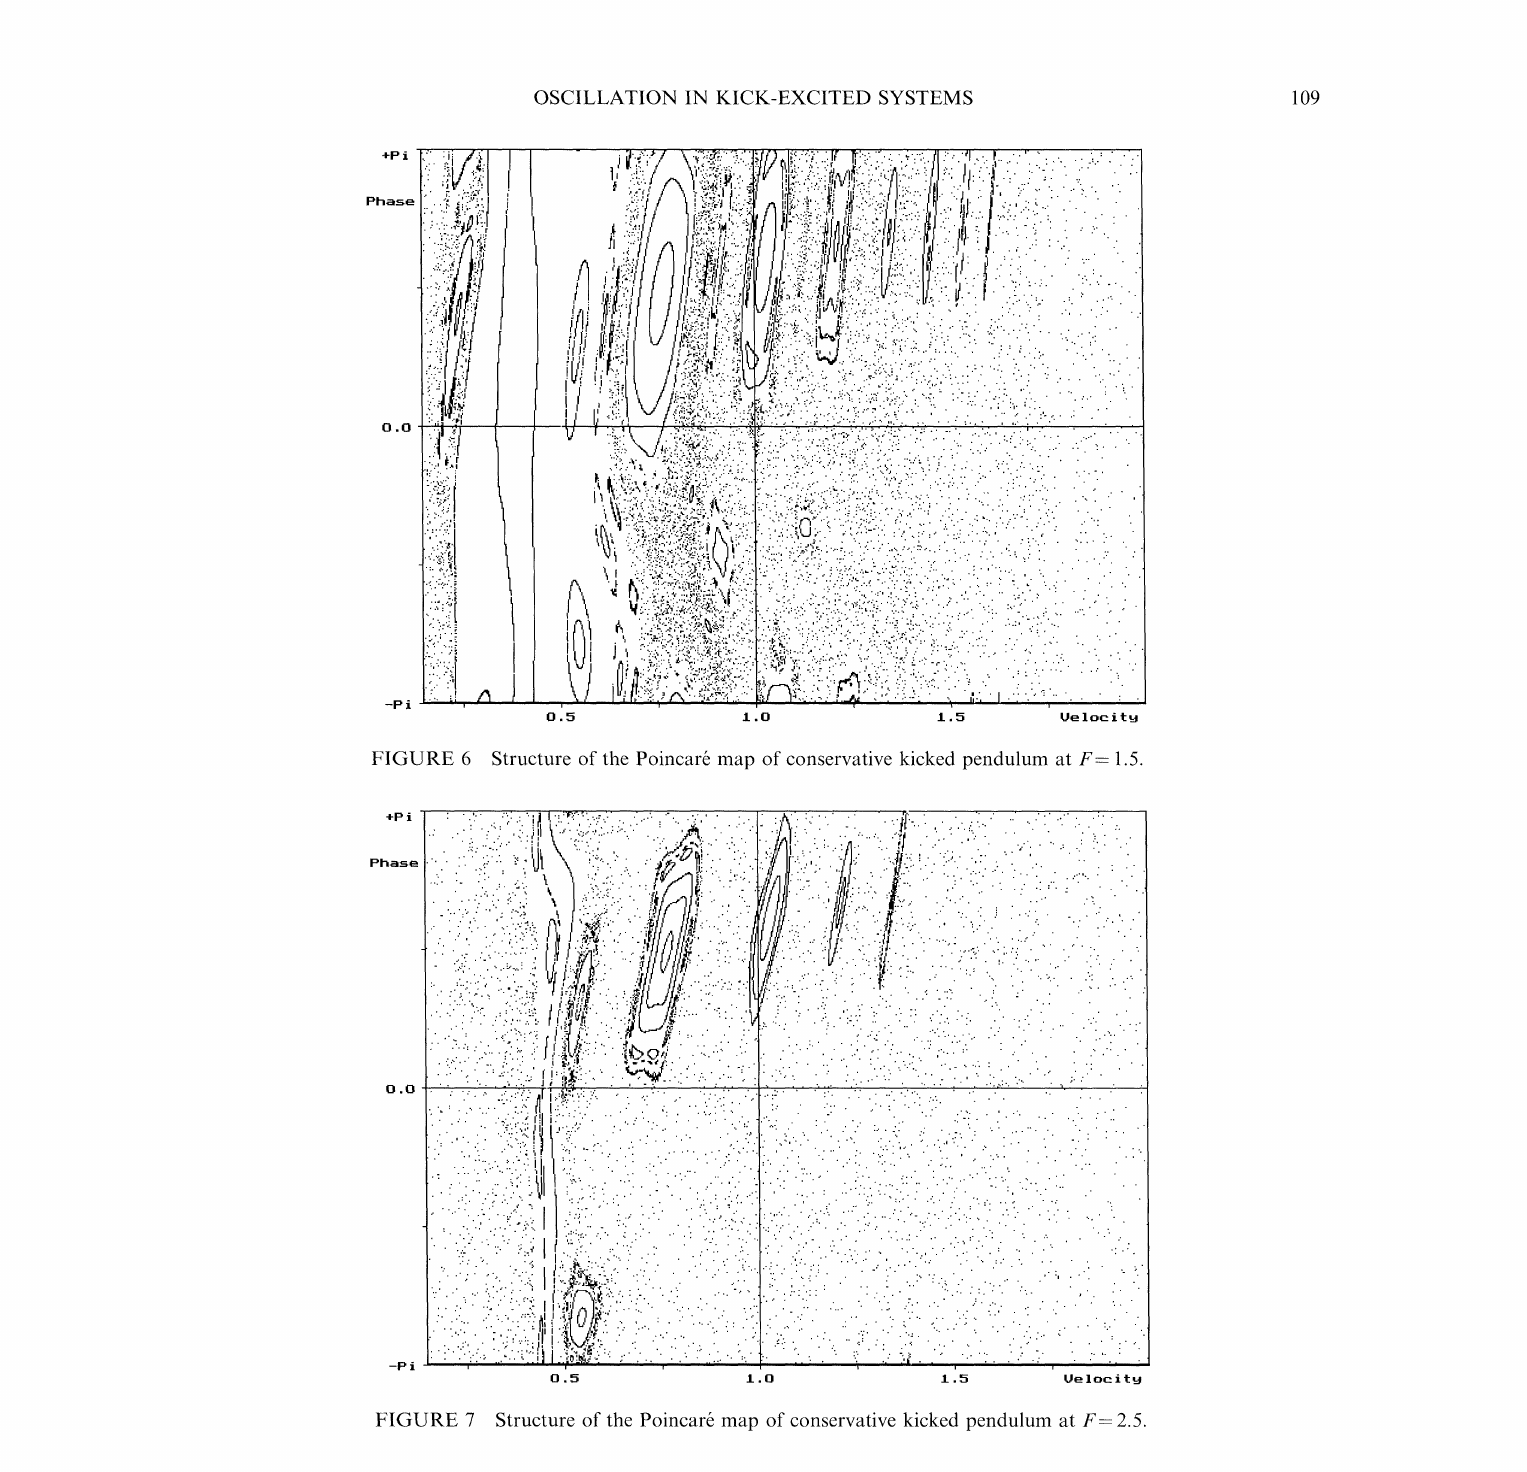
FIGURE 7 Structure of the Poincarb map of conservative kicked pendulum at